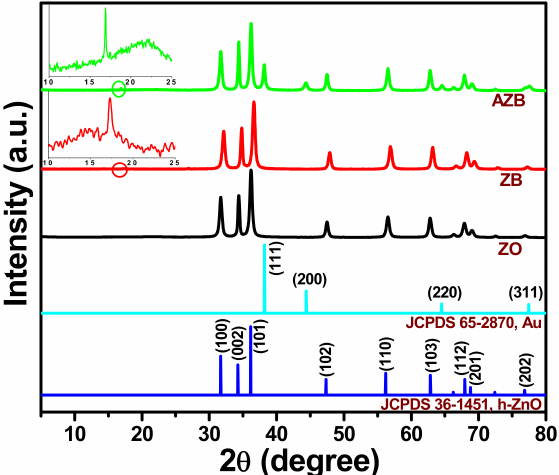
Figure 1. XRD patterns of the ZO, ZB, and Au–ZO– black phosphorus (BP) (AZB) samples. Insets illustrate the enlarged regions in the ZB and AZB spectra marked by the red